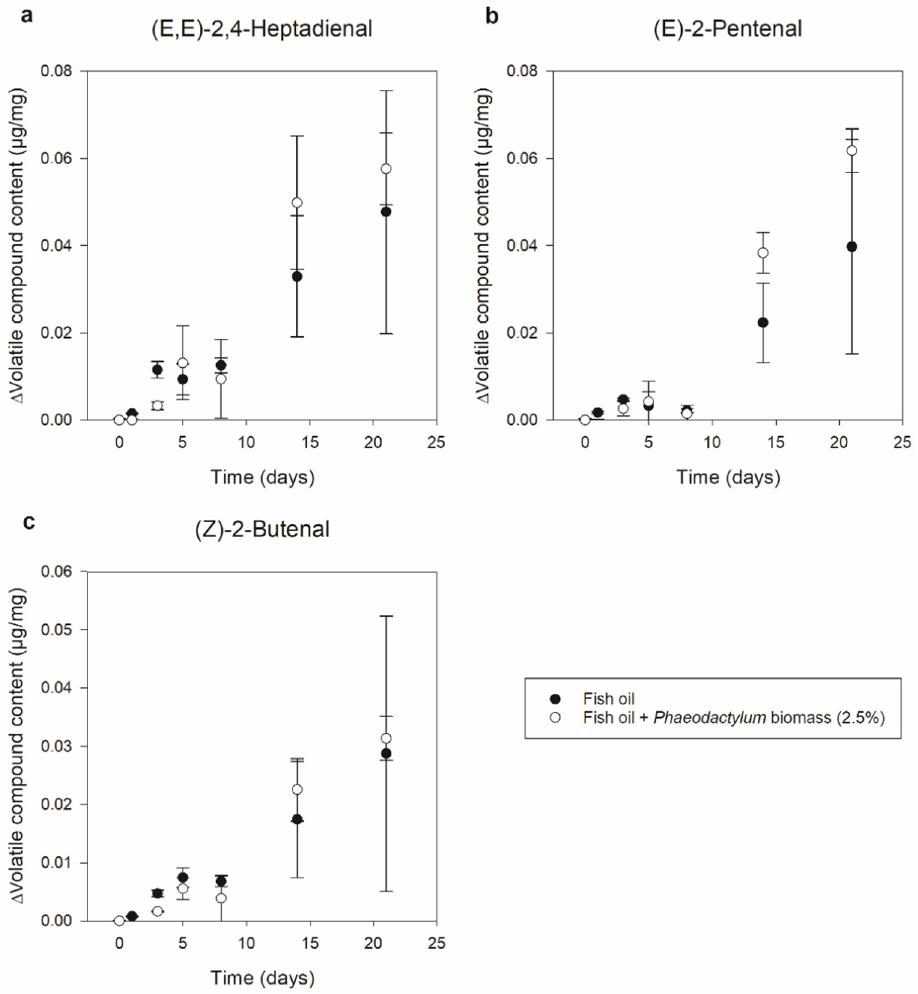
Figure 3. Secondary oxidation of fish oil with (white symbols) and without (black symbols) 2.5% Phaeodactylum biomass addition during 21 days of storage at 37 °C. The content of volatile compounds originating from lipid oxidation [(E,E)-2,4-Heptadienal ( a ), (E)-2-Pentenal ( b ) and (Z)-2-Butenal ( c )] in µg/mg (mean ± sd, n = 2) is expressed in delta values, representing the relative increase or decrease compared to day zero. Information on statistical significance can be found in Supplementary Materials (Table S2).